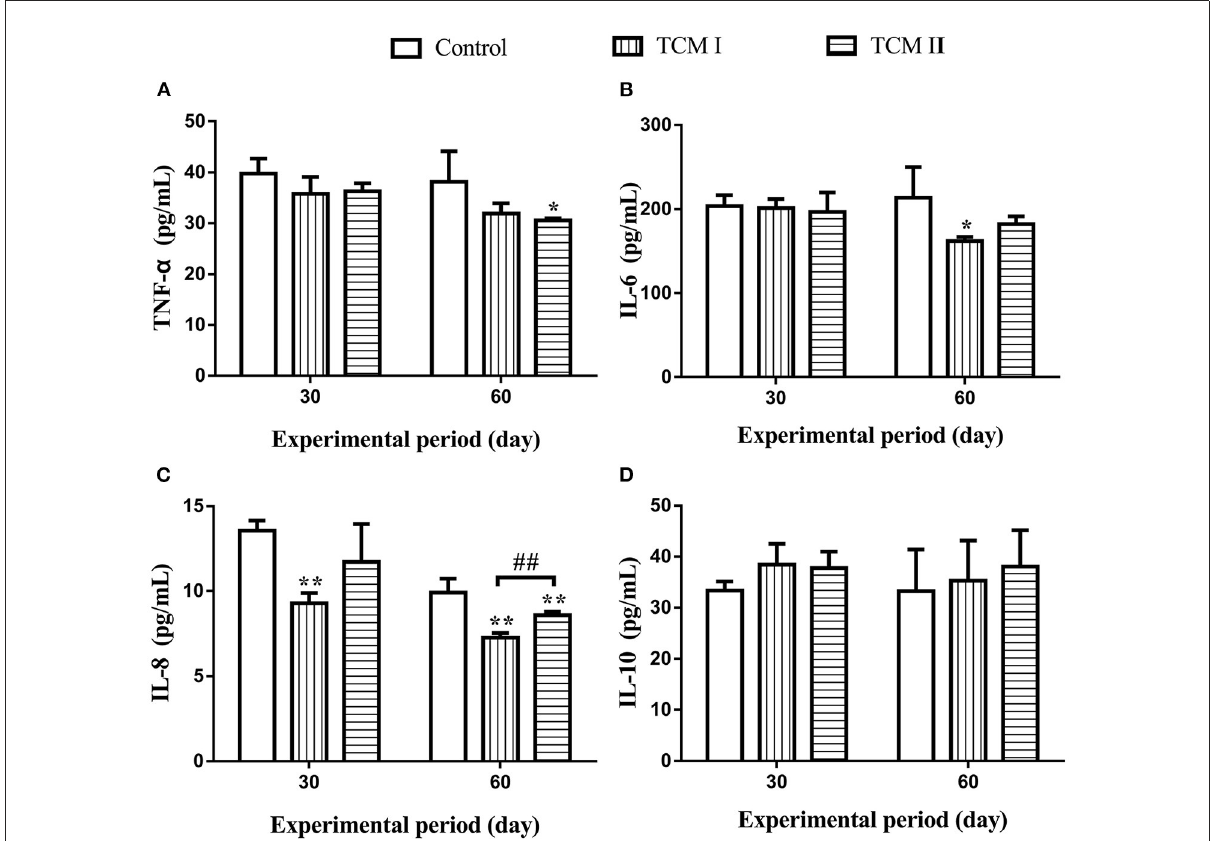
FIGURE2 Determination of (A) TNF- α , (B) IL-6, (C) IL-8, and (D) IL-10 levels in serum on days 30 and